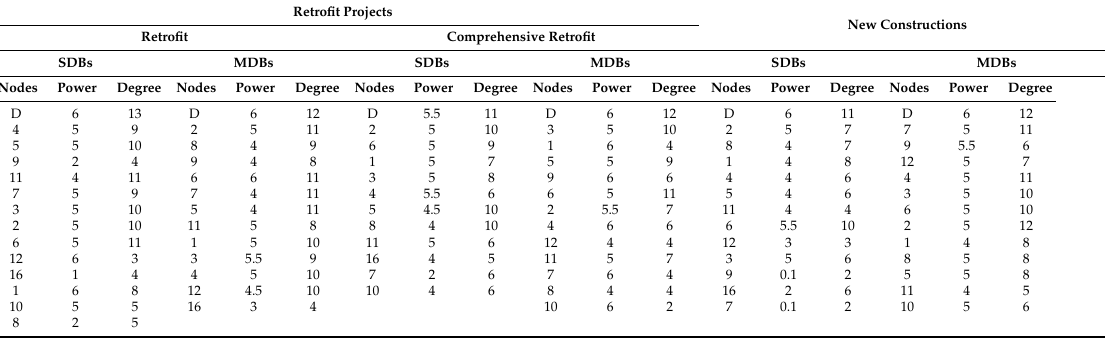
Table A10. Numerical output stakeholder networks classified according to building typologies and project types in the United Kingdom